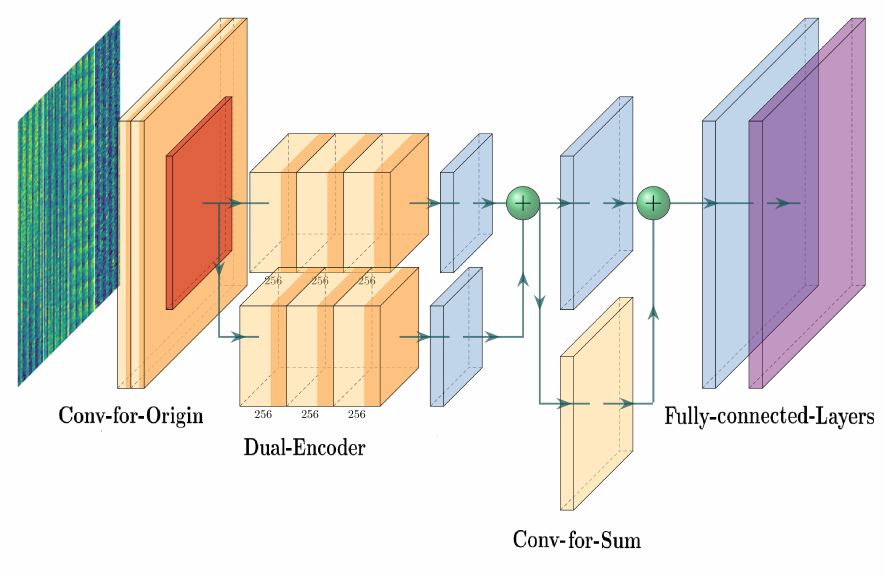
Figure 2. Architecture of the proposed DECC